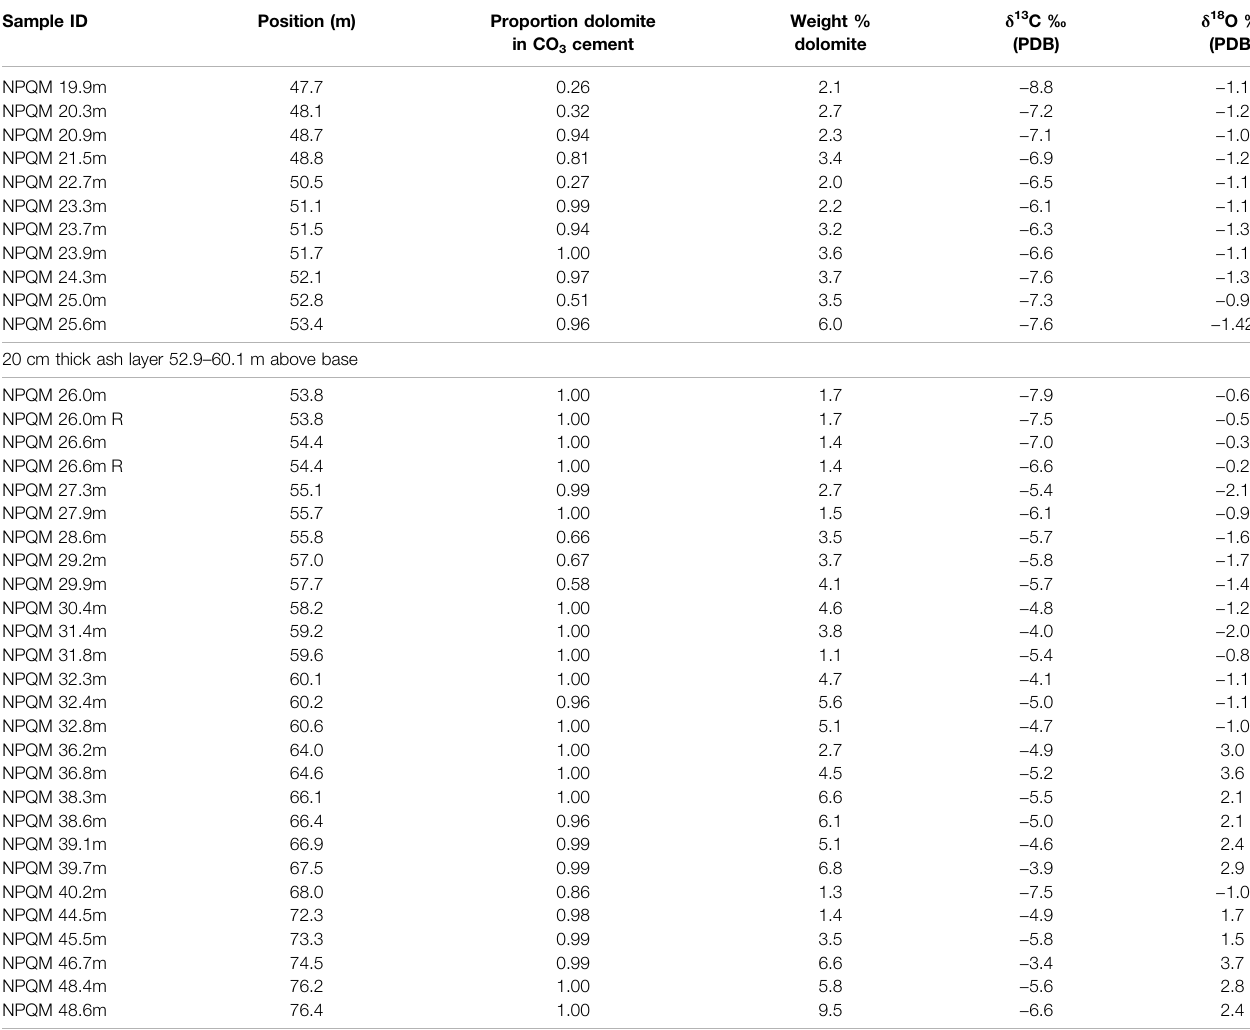
TABLE 9 | ( Continued ) Results of analysis of dolomite cements from Caprock Canyons State